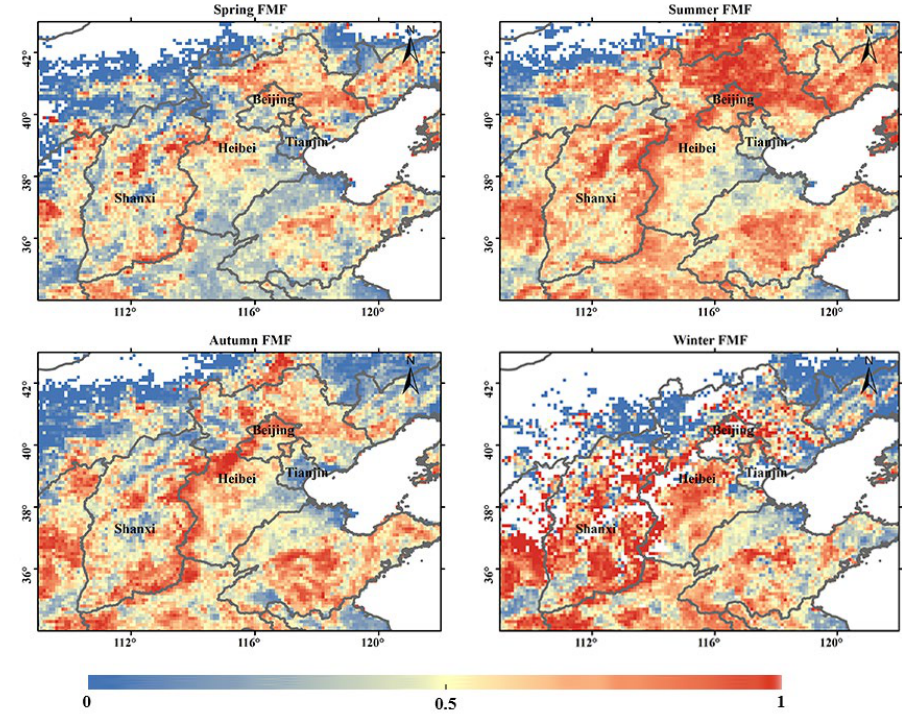
Figure A1. FMF seasonal average spatial distribution of North China in 2017.